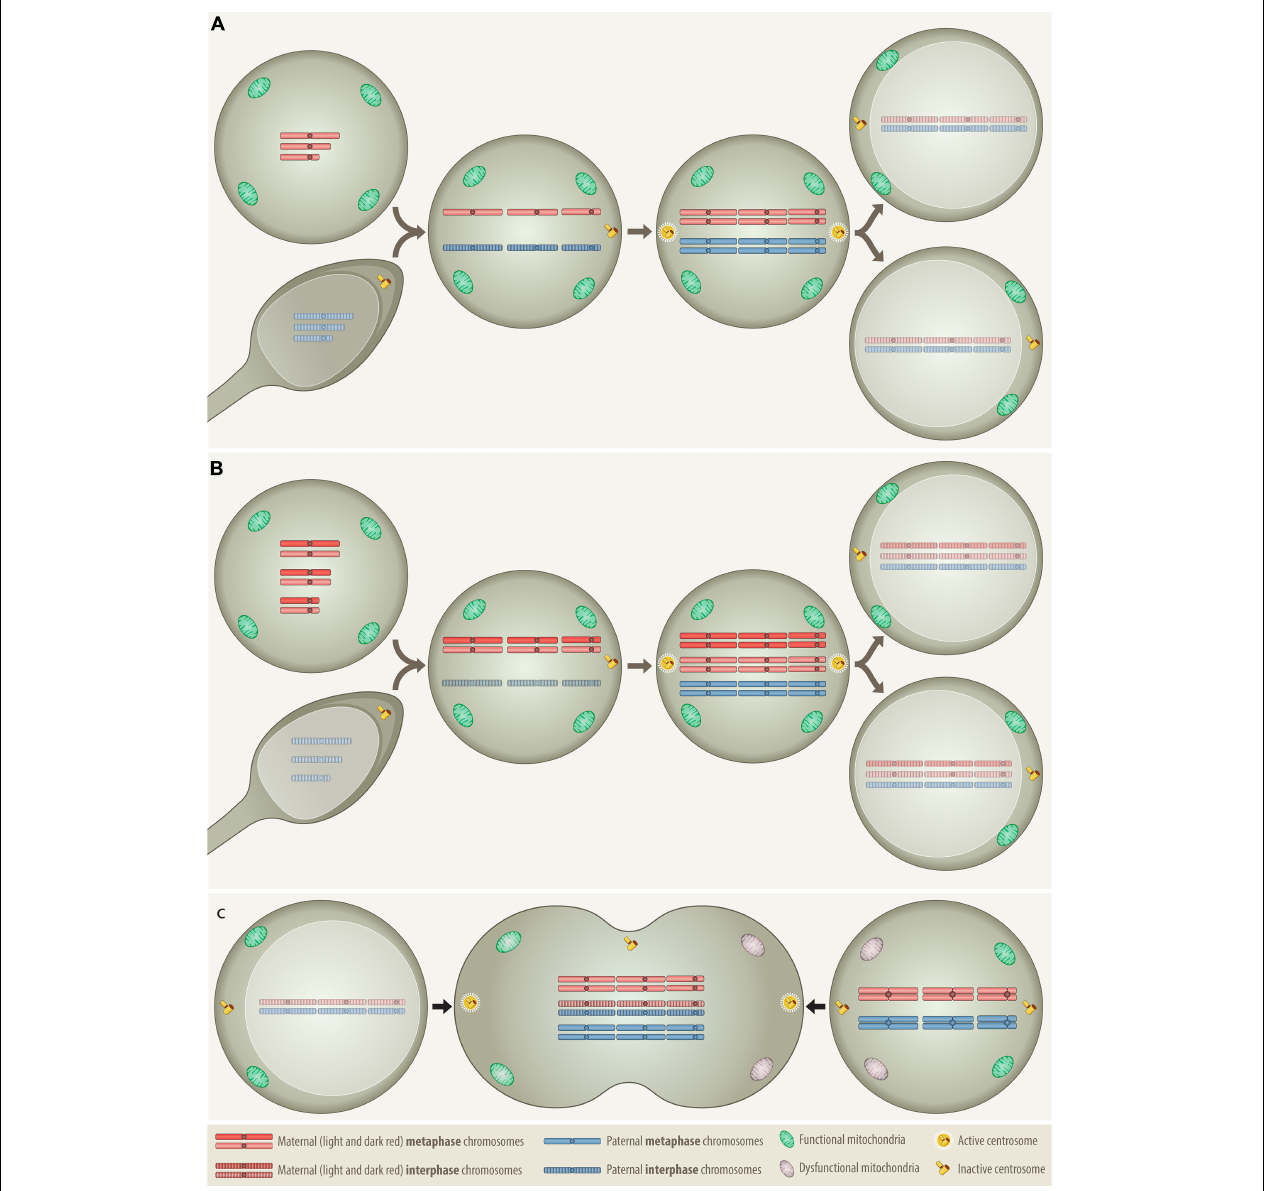
FIGURE 1 | Comparison of the distribution patterns of chromosomes, centrosomes and mitochondria in three different types of cell fusion: (A) a haploid oocyte with a haploid sperm, (B) a diploid oocyte with a haploid sperm, and (C) a mitotic cell with a G0/G1 cell. Fertilization and somatic cell fusion are closely related processes that share many physical and functional properties. To enable the amalgamation of the nuclear material of the involved cells, at least one of the fusion partners needs to be in mitosis, because only a mitotic cell can supply the essential cytoplasmic components that promote the breakdown of nuclear membrane and condense the interphase nucleus into chromatid chromosomes. The combined set of chromosomes must then be accurately allocated to two daughter cells, which is best achieved with the help of a single pair of properly functioning centrosomes. Only daughter cells that receive at least the equivalent of a complete haploid set of chromosomes together with an adequate number of functional mitochondria can survive. (A) In case of normal fertilization, the haploid oocyte provides the power-supplying mitochondria as well as the essential hospital mitotic environment with all the essential components that are necessary to condensate the interphase nucleus of the intruding haploid sperm into individual chromatids, whereas the sperm contributes the prepared centrosome Anlage , which upon fusion is converted into properly functioning centrosomes (Clift and Schuh, 2013). Following duplication of both haploid sets of chromosomes the cell divides and generates the first pair of diploid daughter cells. (B) The formation of a digynic triploidy, which results from the fusion of a diploid oocyte with a haploid sperm, follows essentially the same track. Since digynic triploid zygotes also contain only one single pair of active centrosomes, they can engage in relatively normal mitosis so that all progenitor cells will inherit a stable triploid set of chromosomes. Owing to the consequences of meiotic recombination, homologous chromosomes in diploid oocytes may still contain distinguishable heterozygous regions (Hassold and Hunt, 2001). (C) The somatic type of cell fusion alluded to herein, fuses a mitotic with a G0/G1